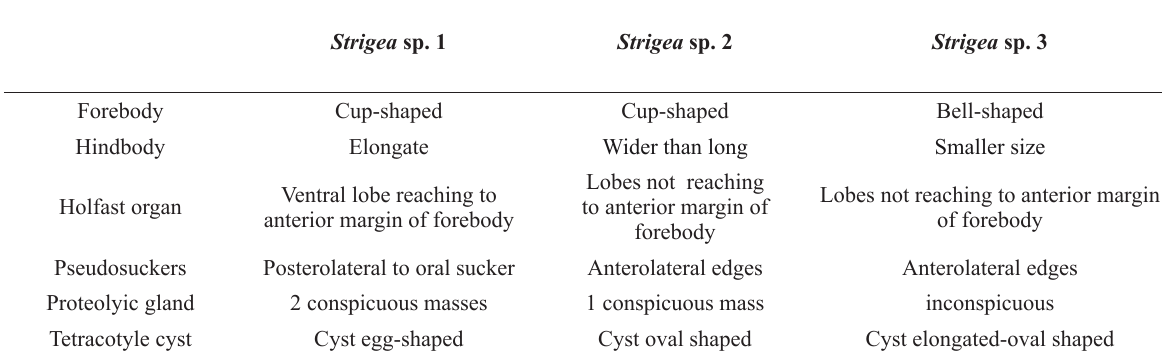
Morphology differences between strigeid metacercariae recorded in frogs from Chaco region, Argentina. Strigea sp.